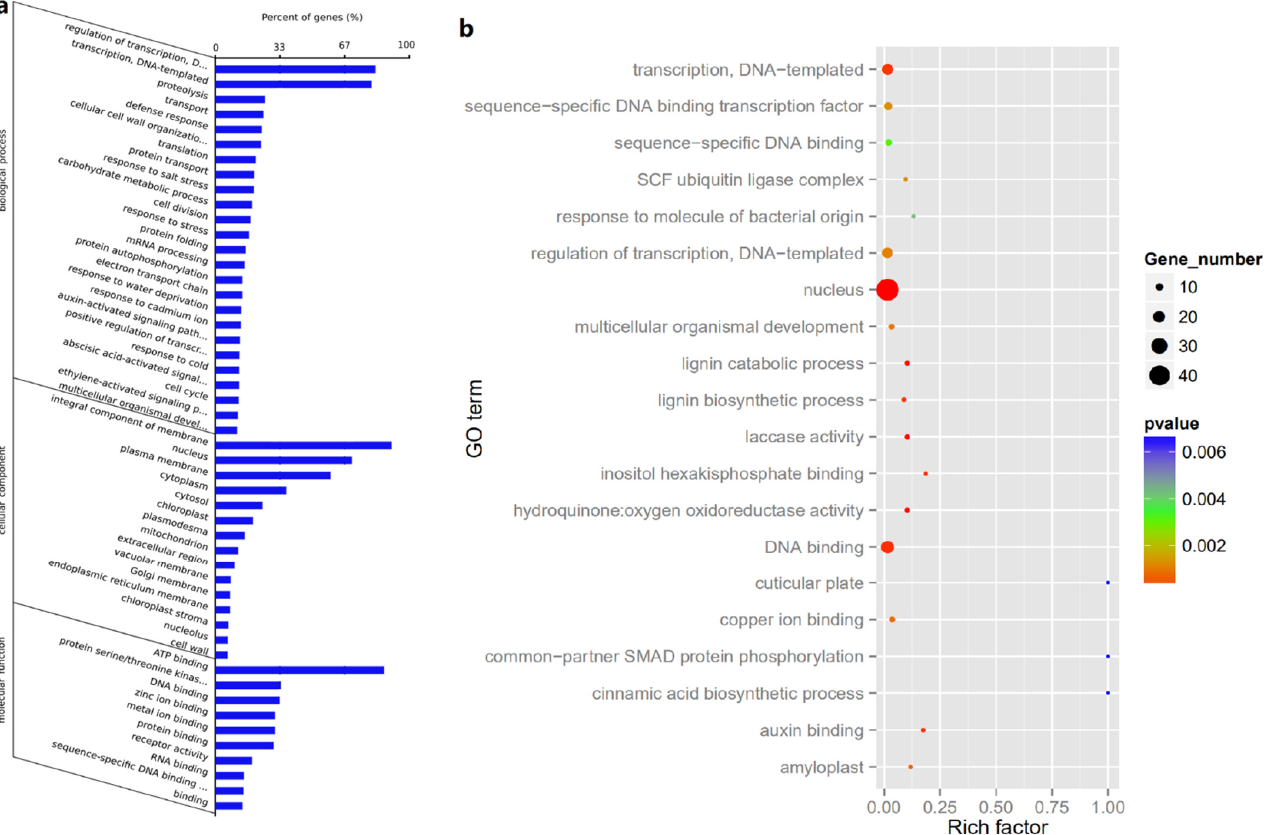
Figure 6. ( a ) GO categories and distribution, and ( b ) scatterplot distribution map of genes targeted by identified miRNAs in the seeds of tea oil camellia.